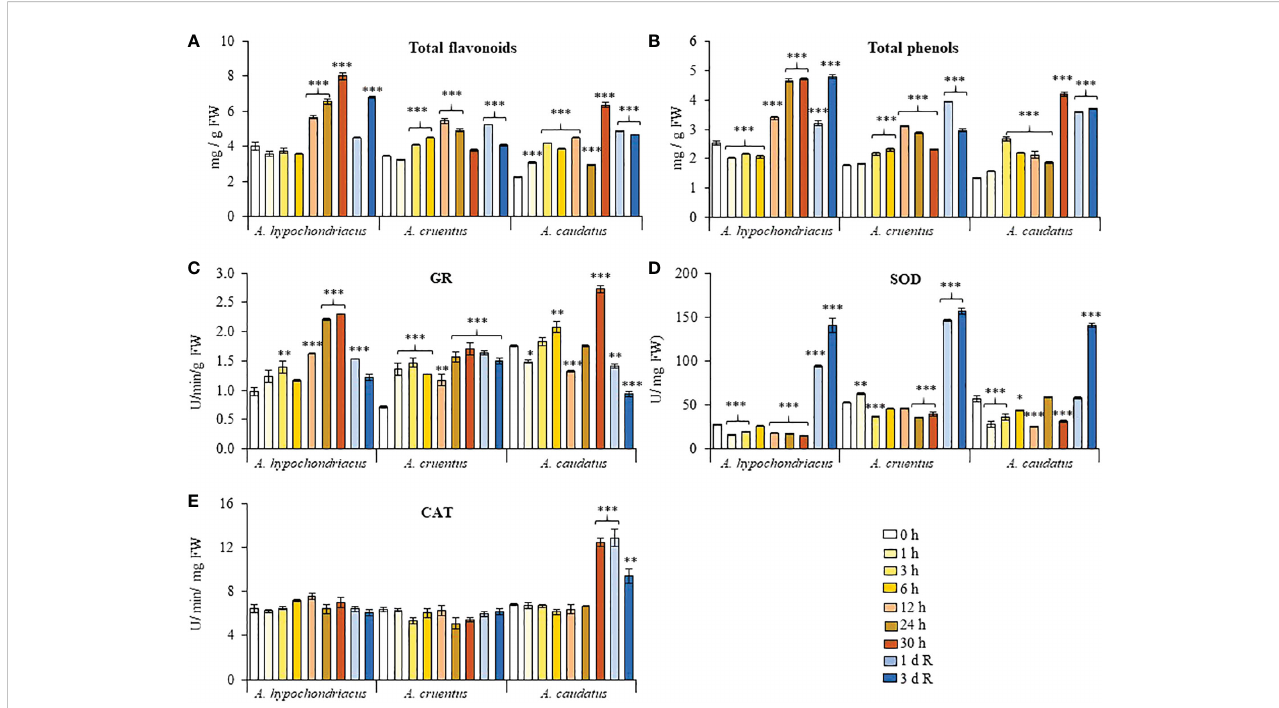
FIGURE 5 Fluctuation in the levels of antioxidant compounds and enzymes recorded during heat shock and subsequent recovery in grain amaranth plants. Changes in the levels of (A) total fl avonoids, (B) total phenols, (C) glutathione reductase, GR, activity (D) superoxide dismutase, SOD, activity and (E) catalase, CAT, detected in leaves sampled from grain amaranth plants at the V1 development stage subjected to heat shock (HS) for 0, 1,3, 6, 12, 24, 26 ( Amaranthus cruentus ) or 30 h ( A. hypochondriacus and A caudatus ) and after 1 (1 d R) and 3 (3 d R) days of recovery from HS under optimal conditions. The bars represent the mean value (n = 30) ± SE. Asterisks over the bars represent statistically signi fi cant differences within species at P ≤ 0.05 (*), P ≤ 0.01 (**) or P ≤ 0.001 (***); one-way ANOVA and Tukey Kramer